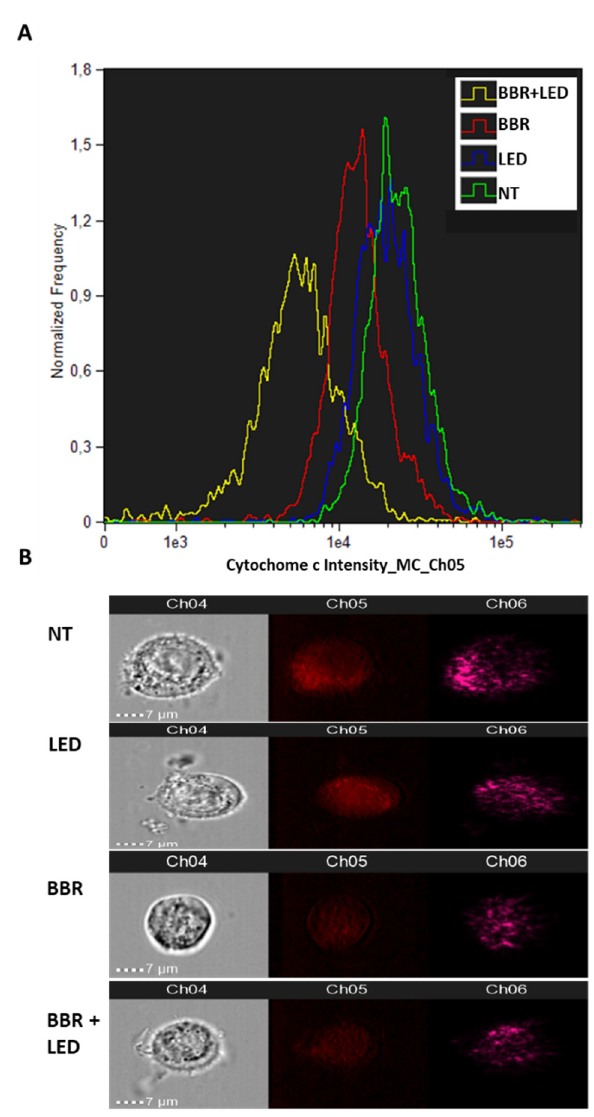
Figure 12. Cytochrome c analysis. Amnis ImageStream MkII flow cytometry analysis of Cytochrome c expression in T98G cells as untreated (NT), exposed to LED stimulation (LED), BBR (200 μ g/mL for 4 h) administration and with the combined BBR + LED ( A ), analyzed after 24 h p.t. Trypsinized cells were analyzed for bright field (Ch04) and for Cytochrome c fluorescence (Ch05) at 60× magnification. Intensity plot of Ch05 is reported (A) with the following average values: NT = 23,185; LED = 21,808; BBR = 13,042; BBR + LED = 5394. Representative cell images are reported ( B ). Ch06, scatterplot.